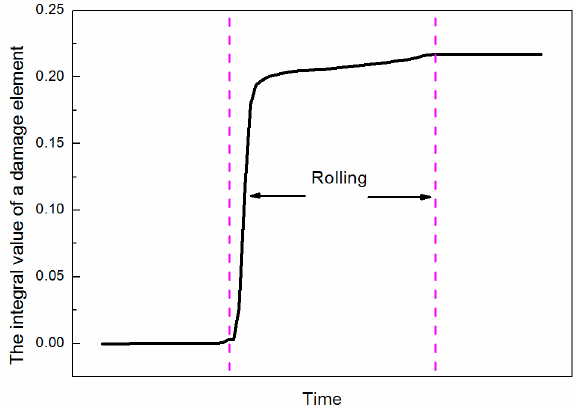
Figure 11. Variation of the integral value of a damage element along with the rolling progress.